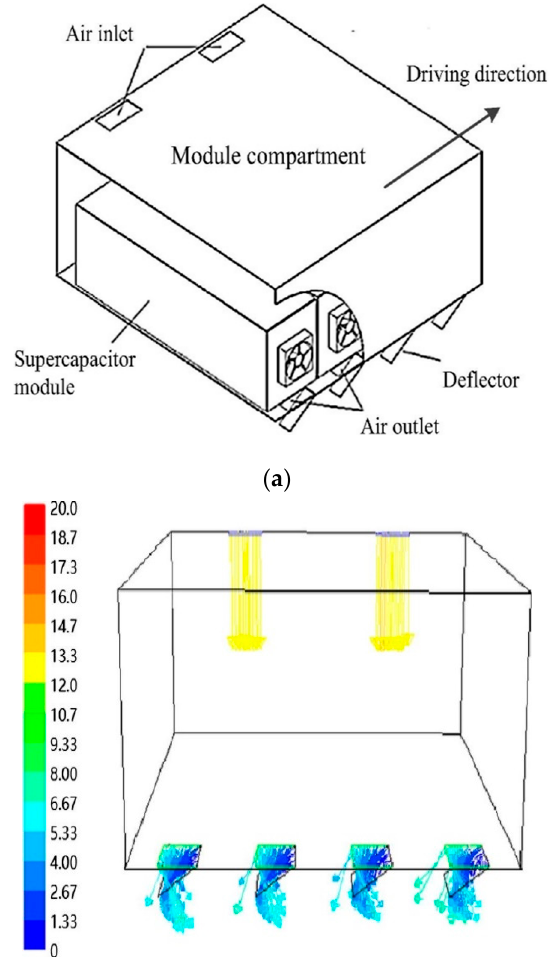
Figure 16. ( a ) Illustration of the optimization and ( b ) optimization of velocity vectors at the entrance and exit of the compartment, reproduced with permission from [27]. Copyright 2016, Elsevier.